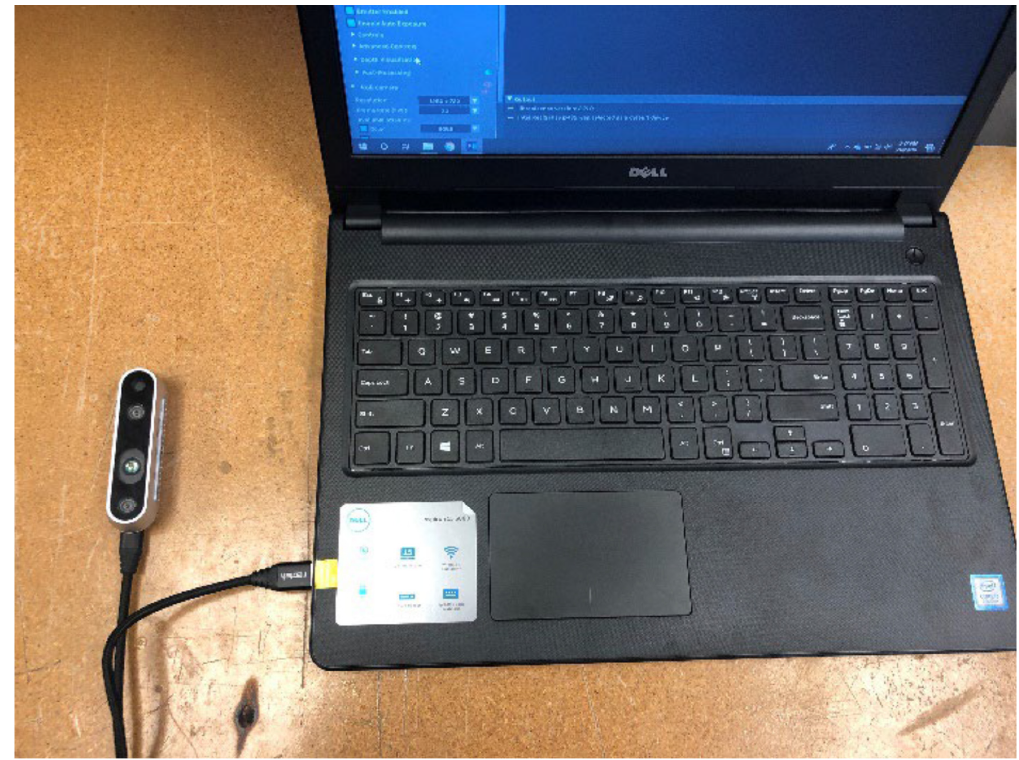
Figure 3. Intel RealSense TM camera and HUGS laptop.